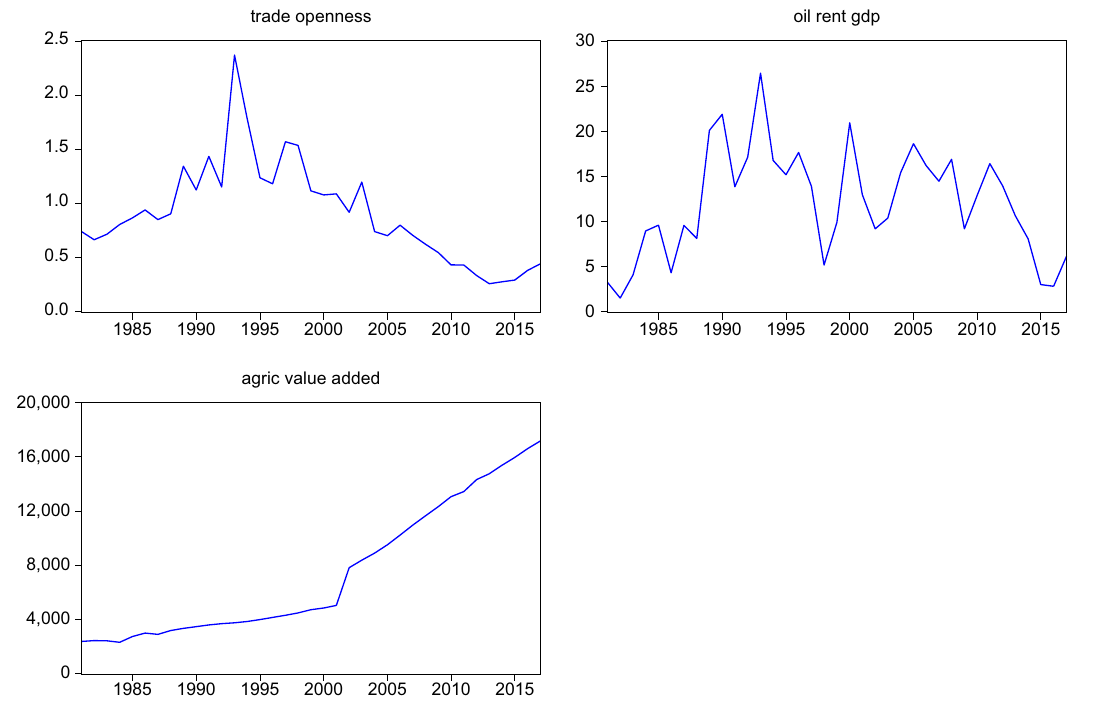
Figure 1: Trends of trade openness, oil rent GDP ratio and agriculture value added.